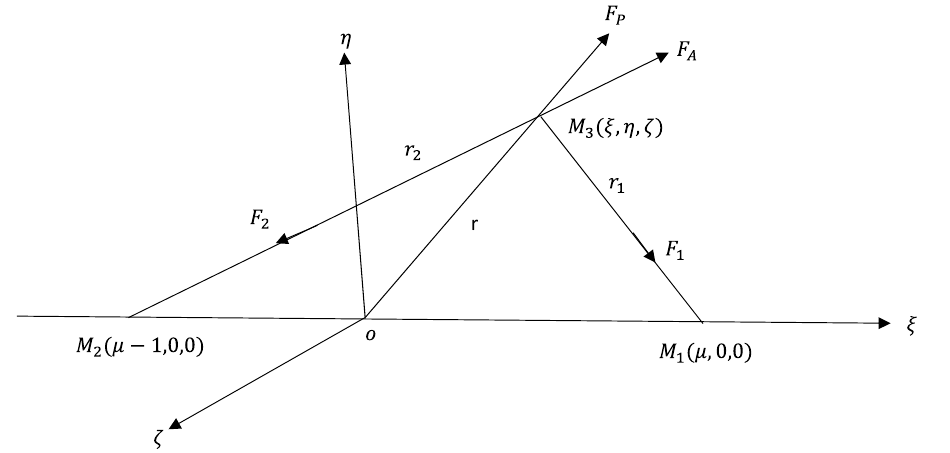
Figure 1. Configuration of the